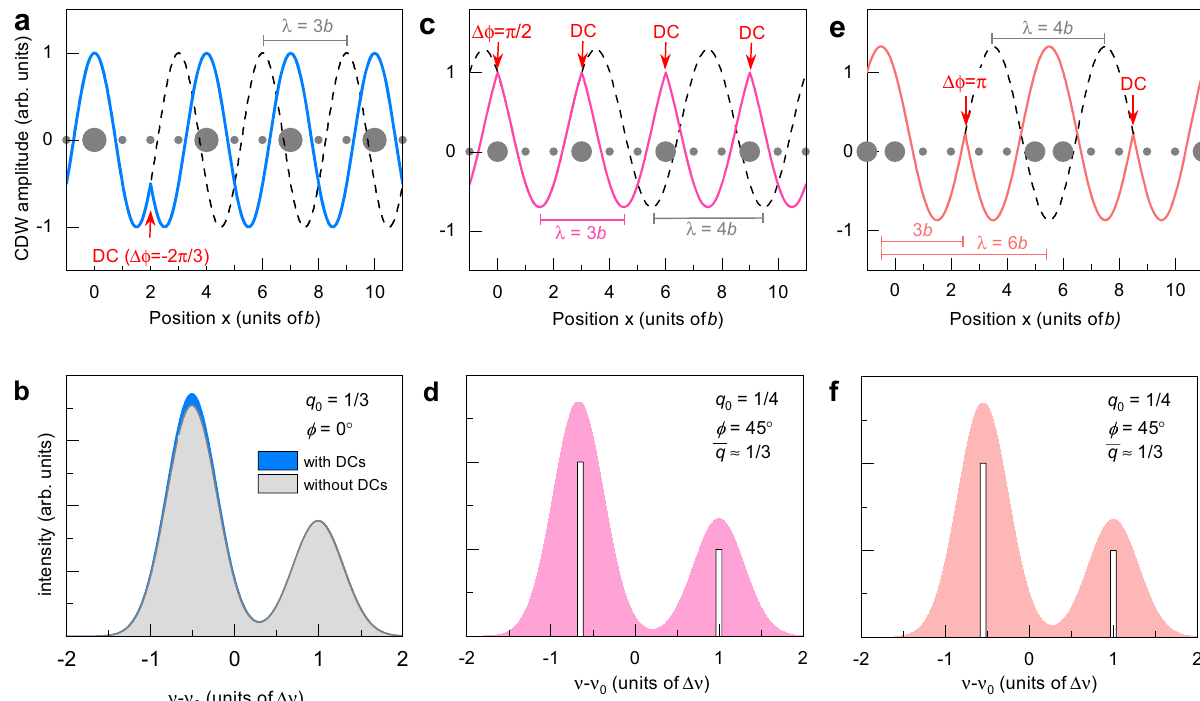
Fig. 6 Effect of discommensurations (DC). a A negative phase slip of − 2 π /3 at position 2 of an undistorted λ = 3 b modulation (black dotted line) increases the region of minimal charge density. As the effective separation between maxima increases, negative phase slips, if occurring repeatedly, lead to a longer period. b Histogram of the modulation shown in ( a ): − 2 π /3 discommensurations increase the left peak intensity but, in the diluted limit (fewer than 1 DC per 10 sites), the change in area ratio of the two peaks is too small to be unambiguously detected. c Starting with an undistorted λ = 4 b modulation of phase ϕ = 45 ∘ (black dotted line), positives phase slip of π /2 at the positions 0 and 3, etc. lead to a compressed modulation of